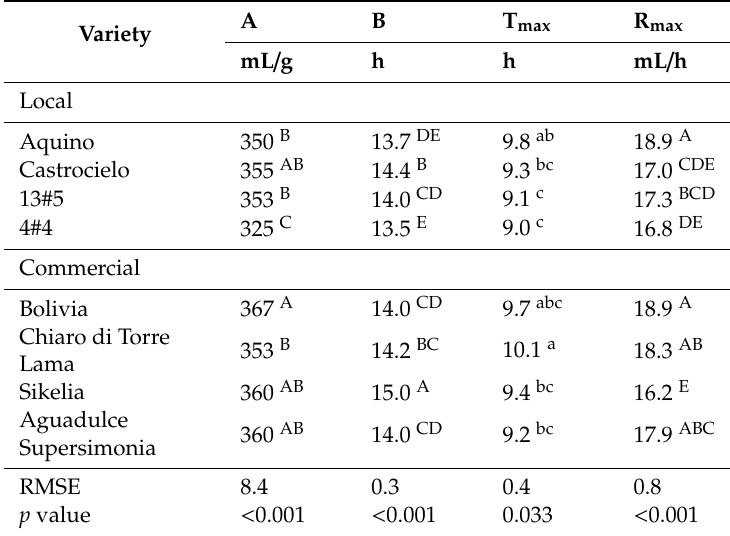
Figure 2. In vitro fermentation characteristics of faba bean varieties; dOM = organic matter degradability (% of incubated OM; p = 0.0007); OMCV = cumulative volume of gas related to incubated OM (mL/g; p = 0.0004). For each parameter: A–C = p < 0.01. Error bar = standard deviation. Table 3. In vitro fermentation characteristics of faba bean The pH values ranged from 6.89 to 6.94 in Castrocielo and Chiaro di Torre Lama, respectively, indicating that after 48 h the incubation was carried out adequately.